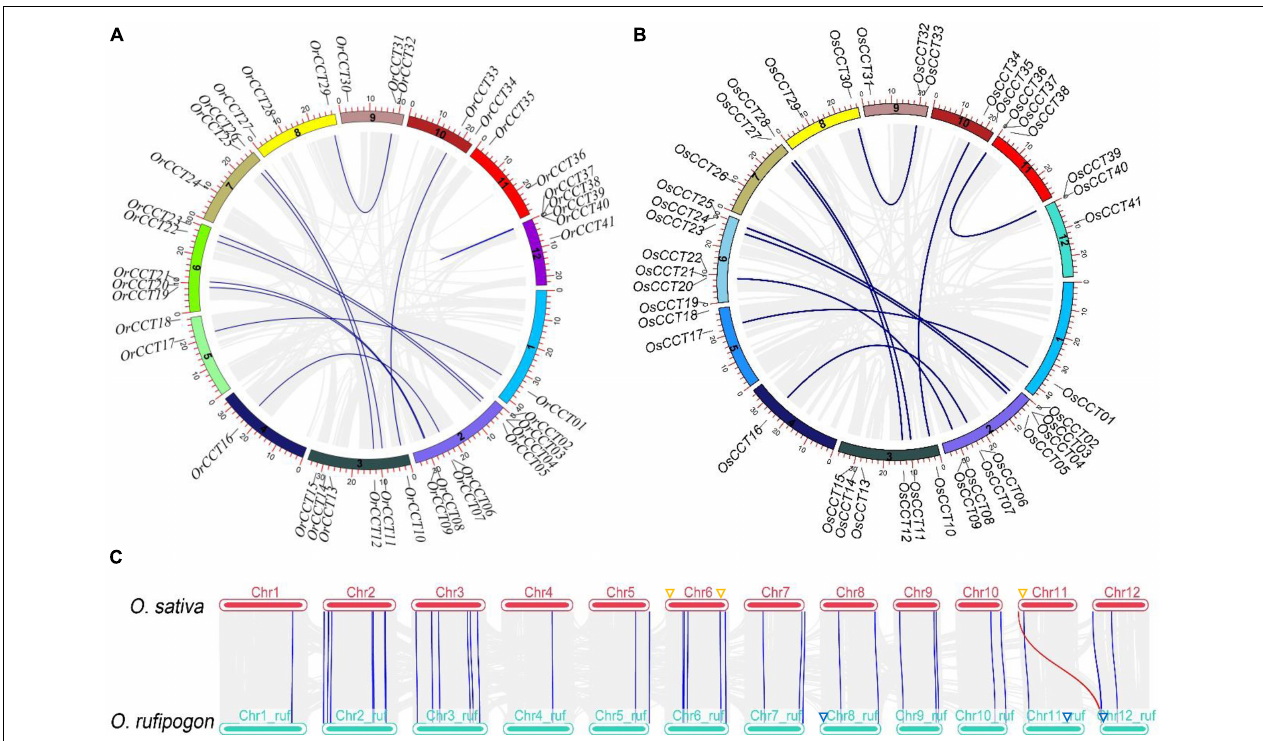
FIGURE 2 | The inter-chromosomal relationship among CCT genes. (A,B) The chromosome distribution and gene duplication events in O. rufipogon (A) and O. sativa (B) . The approximate location of each CCT gene is marked on corresponding chromosomes. The blue lines indicate the duplicated OrCCT genes, and gray lines in the background represent all duplication blocks within genomes. (C) The collinear relationship of CCT genes between O. rufipogon and O. sativa. The blue lines indicate orthologous gene pairs, while the red line shows that the CCT gene was likely generated after the domestication of O. sativa . The specific CCT genes of O. sativa and O. rufipogon are marked with orange and blue triangles on the corresponding positions of chromosomes,